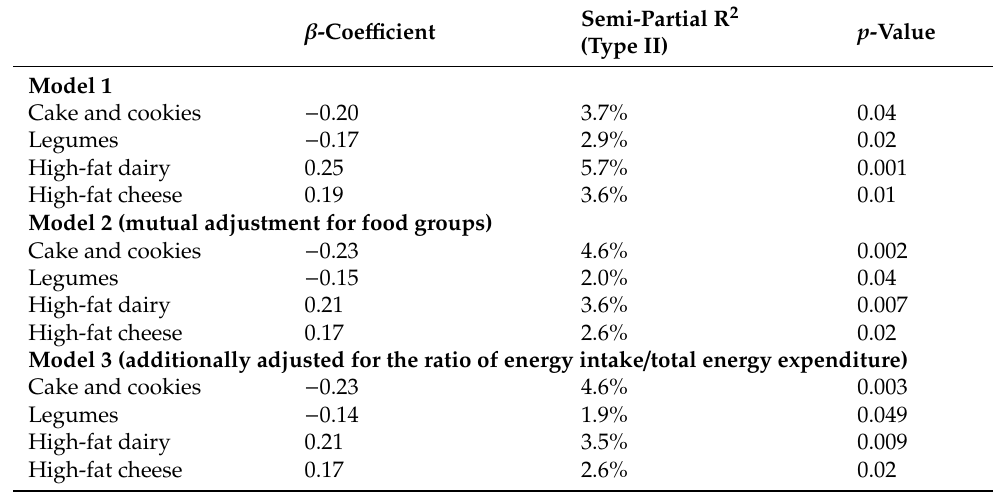
Table 4. Associations between food consumption and liver fat content (%) ( n = 136).